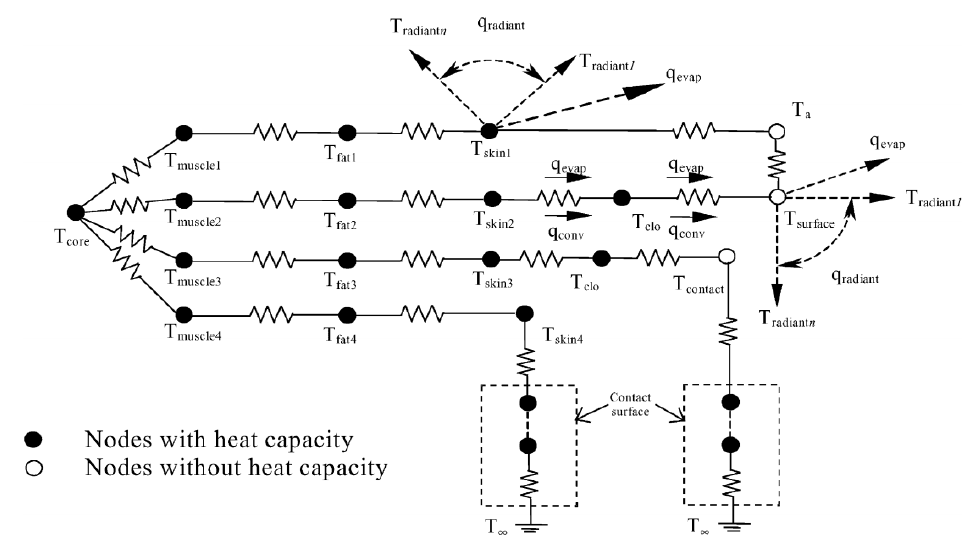
Figure 6. Heat transfer through the human body